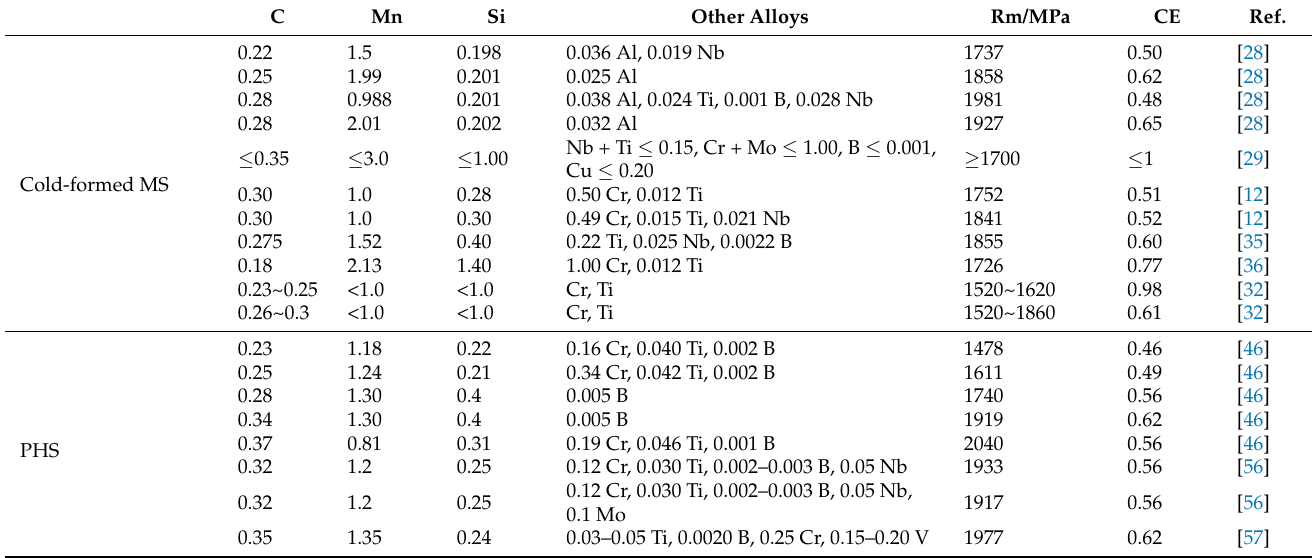
Table 1. Alloy composition, carbon equivalent (CE), and mechanical properties of typical ultra-high- strength cold-formed MS and PHS (tensile strength >1500